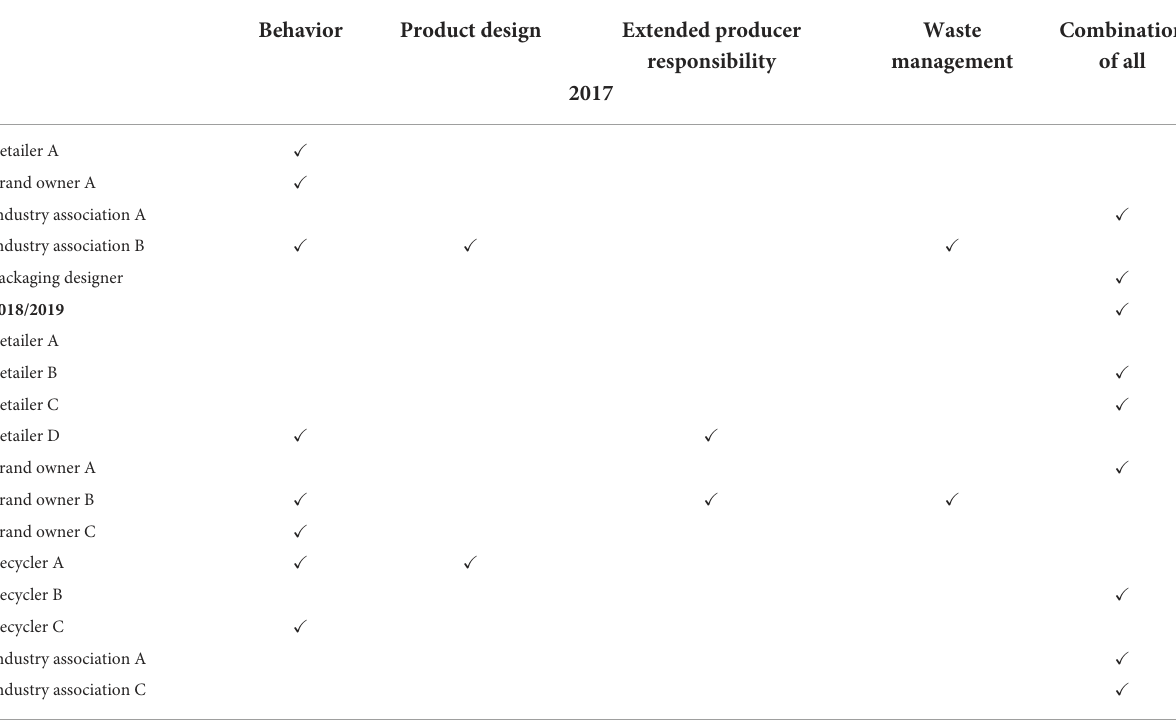
TABLE 5 Stakeholder perspectives on plastic pollution